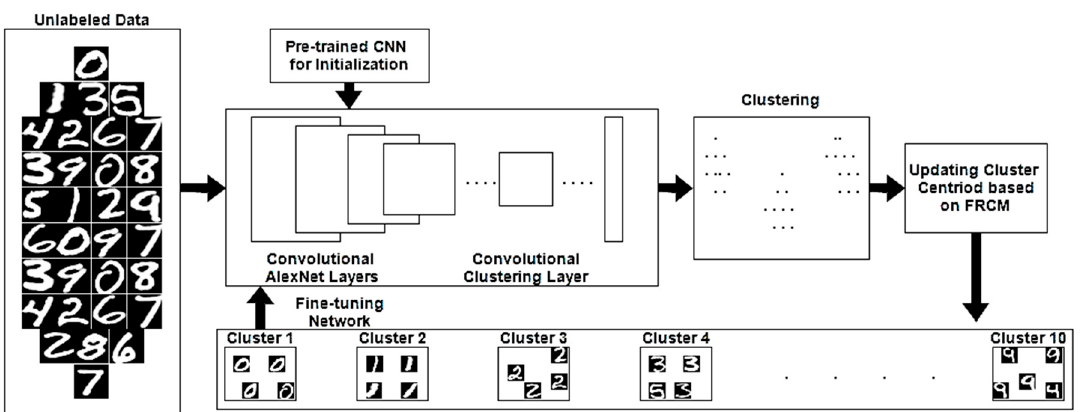
Figure 1. Flowchart of the proposed clustering method for joint representation learning and image clustering.